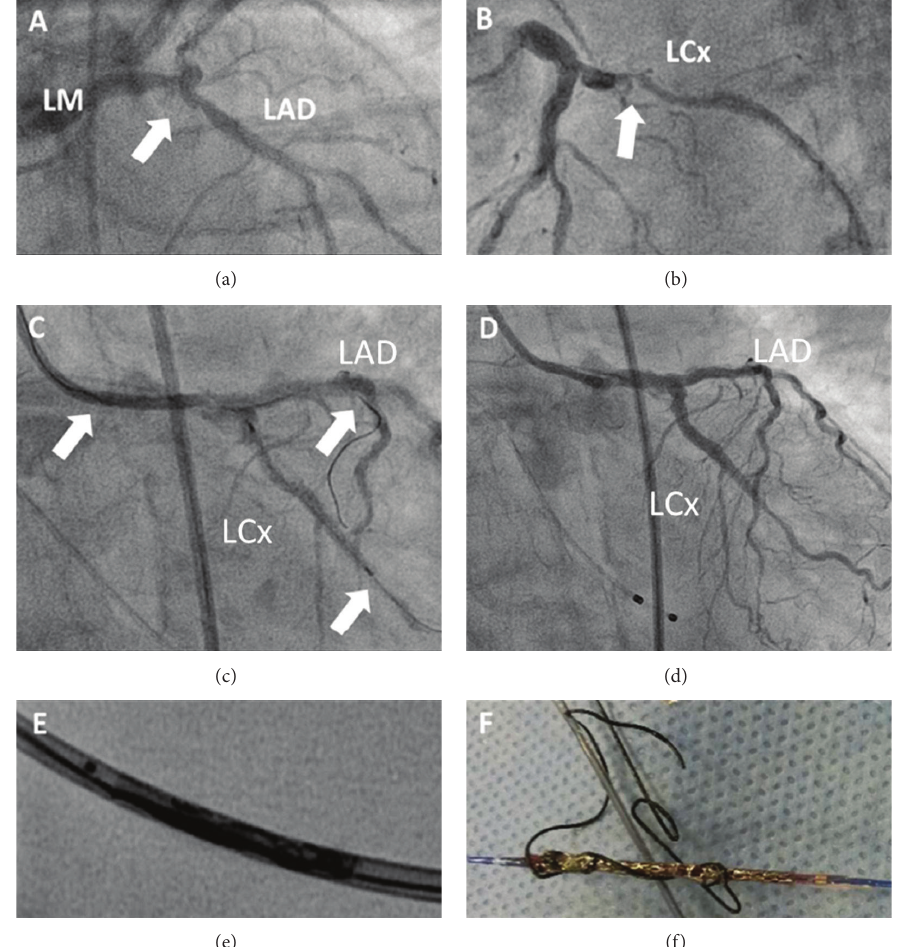
Figure 1: (a) and (b) Angiogram showing severe coronary artery disease with significant stenosis of the distal left main artery (LM) and the proximal left circumflex (LCx) (white arrows). (c) Mini-crush stenting was planned with one wire in the LAD and 2 wires including the buddy wire in the LCx. Advancement of the second stent into the LAD leads to entrapment and distortion of this stent by the buddy wire after successful positioning of the first stent into the LCx. (d) Provisional stenting of the LM-LCx lesion showed a good final result. (e) and (f) Attempts to pull the LCx “buddy wire” failed directly after advancement and before expansion of stents. Forced pullback of the buddy wire tore the LAD stent catheter tip off the shaft, blocking the mid-part of the 7F